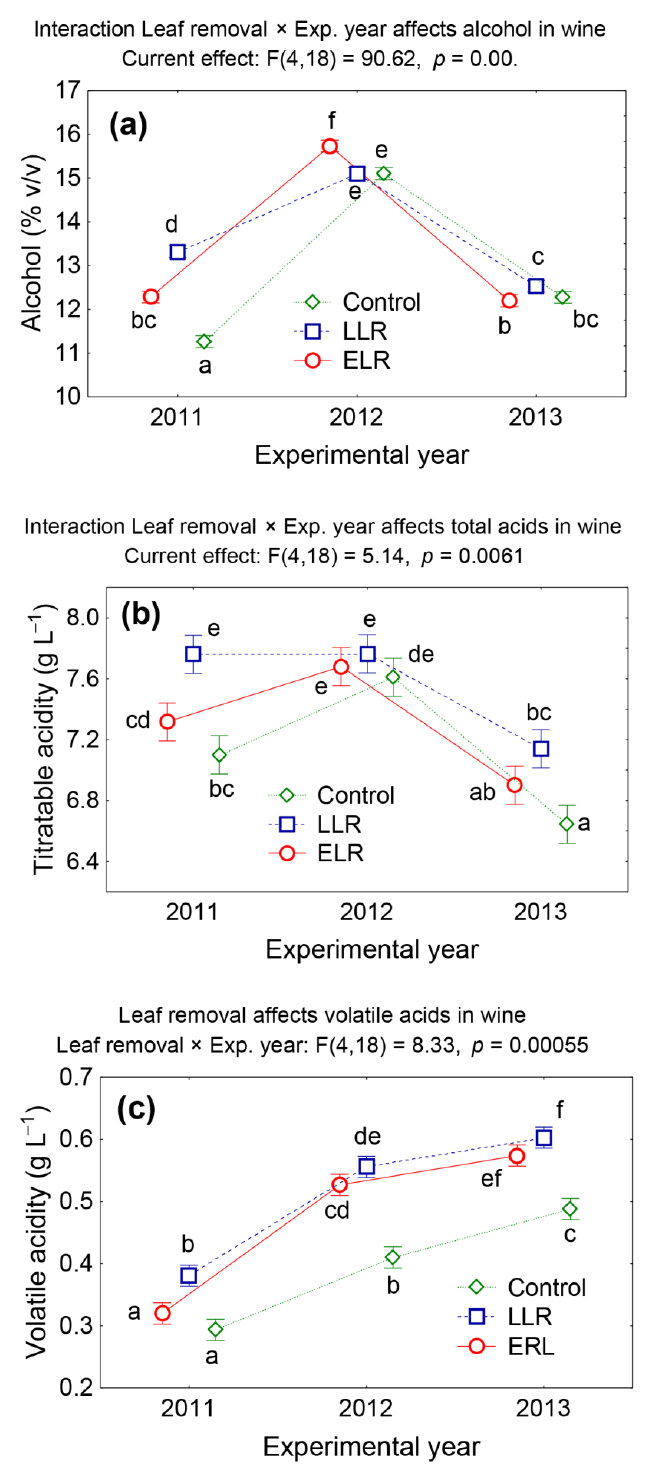
Figure 3. Effect of leaf removal end experimental year on the quality parameters of wine (after 3 6 months of aging). ( a ) Concentration of alcohol (full model R 2 adj. 0.998, F = 612.9, p = 0.000); ( b ) concentration of total acids (full model R 2 adj. 0.98, F = 46.6, p = 0.000000); ( c ) concentration of volatile acids (full model R 2 adj. 0.98, F = 198.0, p = 0.000000). Mean values marked with the same letter are not significantly different at α = 0.05. Vertical bars denote 95% confidence